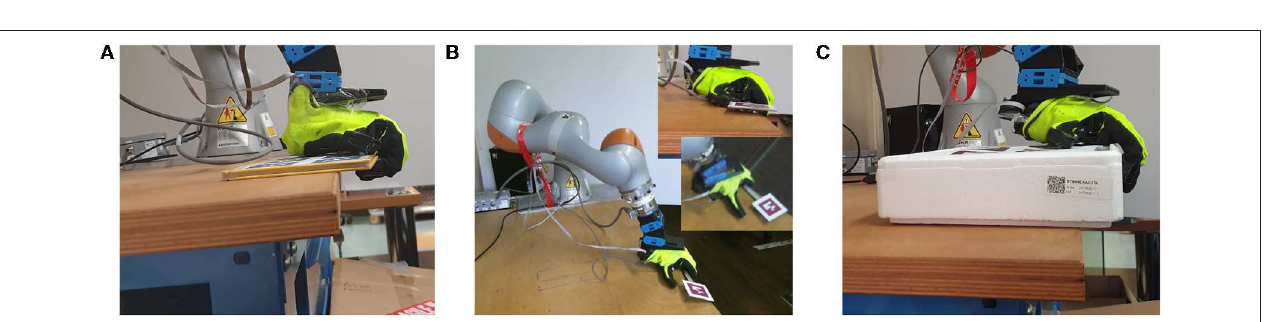
FIGURE 4 | Strategy 1 Continuous Slide and Grasp–Object grasp. (A) Grasp of a book, (B) grasp of a wrench, (C) limitations of the strategy: it does not work with objects with a large